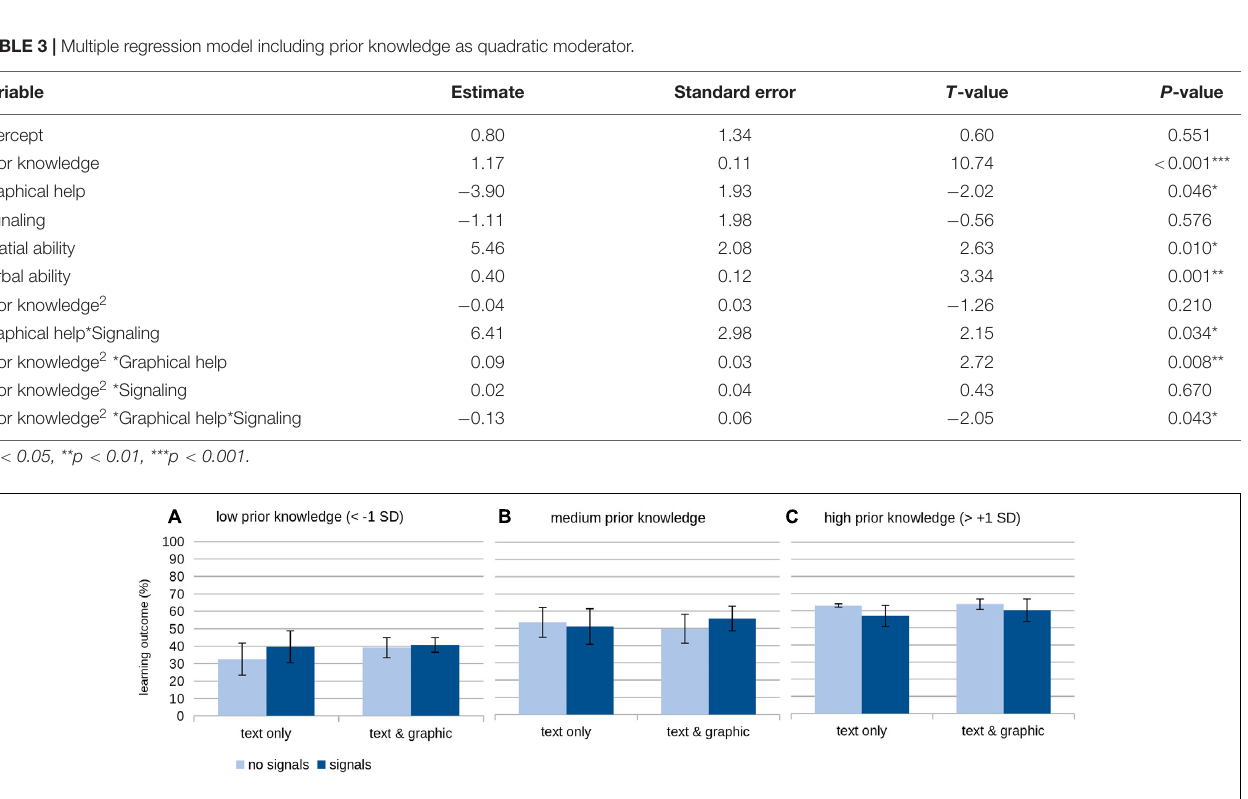
FIGURE 2 | Means and standard deviations of the learning outcome depending on the different help